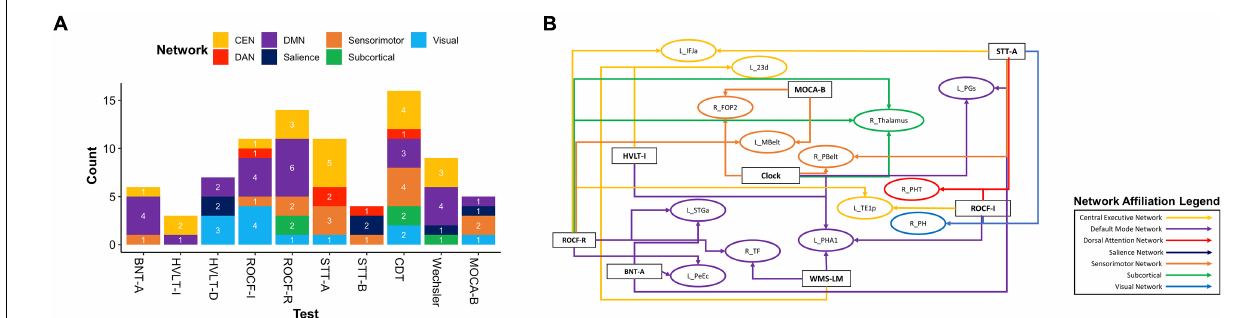
FIGURE 3 | Baseline resting-state fMRI parcels predicting absence of deficits in neuropsychological tests. (A) Parcel to network mapping showed that parcels in the CEN and DMN were most frequently associated with absence of deficit in neuropsychological testing, and these networks were the most common overall. (B) Neuropsychological test to parcel mapping of fourteen parcels which were predictors of good performance in at least two tests. The parcels have been placed in relative anatomical positions, while the colors of the arrows represent the networks associated with the parcels. Each arrow is drawn from the neuropsychological test (rectangle) to a single parcel (oval). CEN, Central Executive Network; DAN, Dorsal Attention Network; DMN, Default Mode Network; BNT-A, Boston Naming Test—Articulateness and Fluency; BNT, Boston Naming Test; HVLT-I, Hopkins Verbal Learning Test—Immediate Memory; HVLT-D, Hopkins Verbal Learning Test—Delayed Recall; ROCF-I, Rey Osterrieth Complex Figure Imitation; ROCF-R, Rey Osterrieth Complex Figure Recall; STT-A, Shape Trail Test—Part A; STT-B, Shape Trail Test Part B.